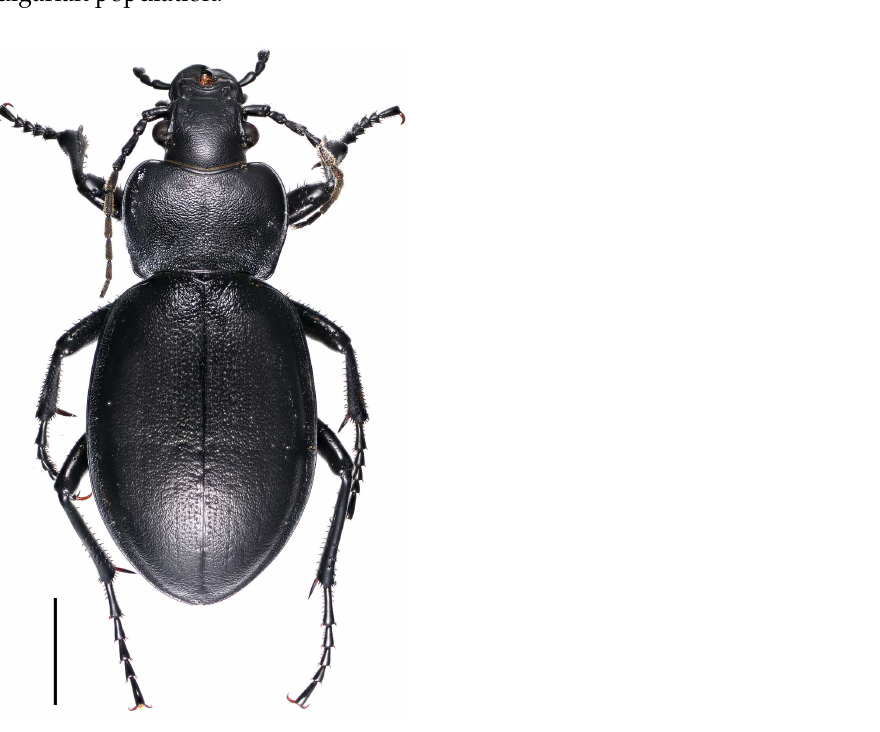
Figure 1. Habitus of the female Carabus bessarabicus from the Chepan Planina. Scale bar 5 mm.